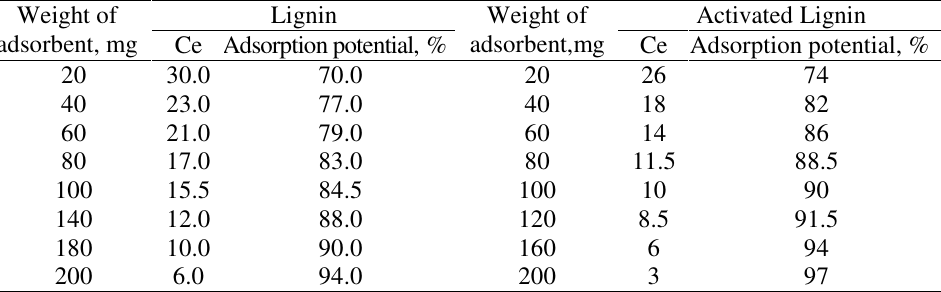
Table 2. Dependence of efficiency of Ni(II) adsorption on adsorption dosage.